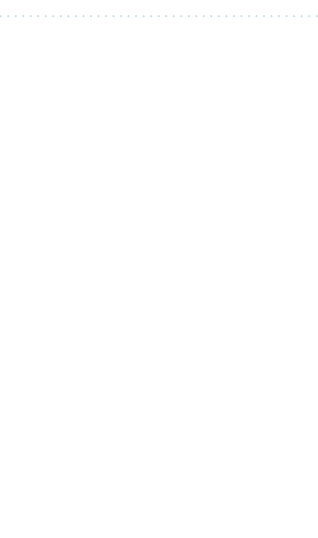
Figure 4. Calculated UV–vis spectra of CuST (solid line) and CuST-Imi (dashed line). All results were obtained using a TD-DFT approximation at the B3LYP/6-311G(d,p) level of theory. Inset: magnification of the spectra in the range of 480–650 nm.